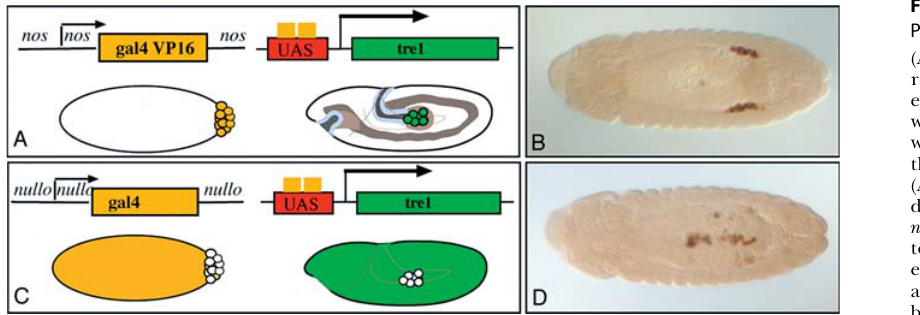
not shown). nullo-GAL4 (C) (yellow) drives expression in all somatic cells at blastoderm stage except for germ cells (green). (B and D) Embryos at stage 13 (top view) stained with anti-Vasa. Anterior is left. Expression of tre1 only in the germ cells rescued the tre1 phenotype (B). Expression